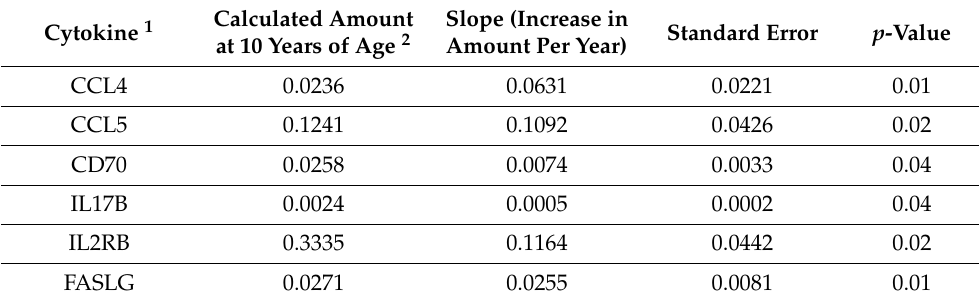
Table 1. The relationship of age and selected cytokine